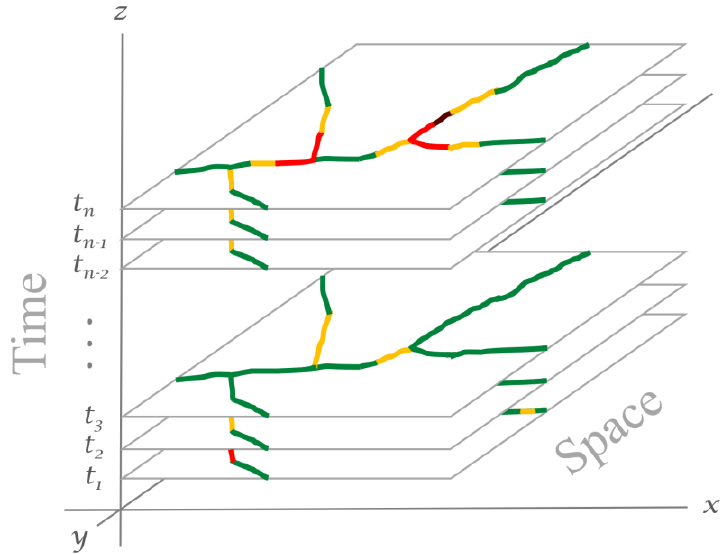
Figure 1. A space-time cube with traffic congestion intensity levels in different colors—green for free flow, orange for light congestion, red for medium congestion, and dark red for heavy conges- tion.